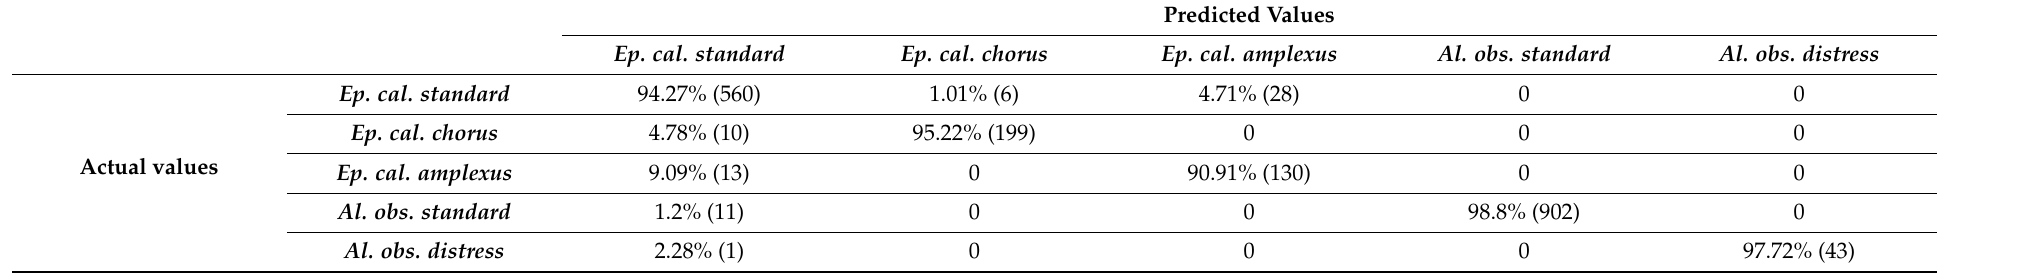
Table 3. Confusion matrix for the first CNN (5